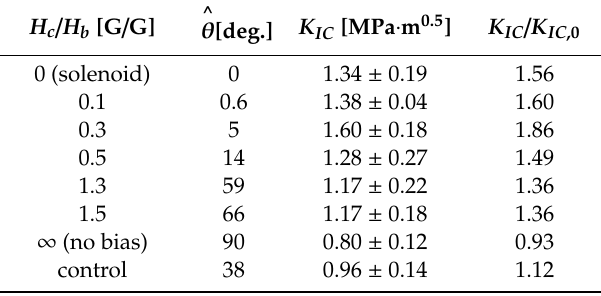
Table 3. Comparison of the fracture toughness of EP / MGF composite (10 wt %) under di ff erent magnetic configurations. The magnetic configuration is depicted as the ratio of the concentration field and the bias field; ˆ θ is the average orientation angle as calculated according to Equation (3). ^ θ [deg.] K IC [MPa · m 0.5 H c / H b [G / G]